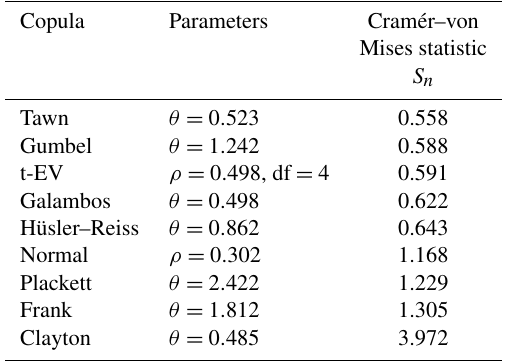
Table 3. Fitted parameters of nine different copulas for sea levels and significant wave heights from buoy observations for the pe- riod